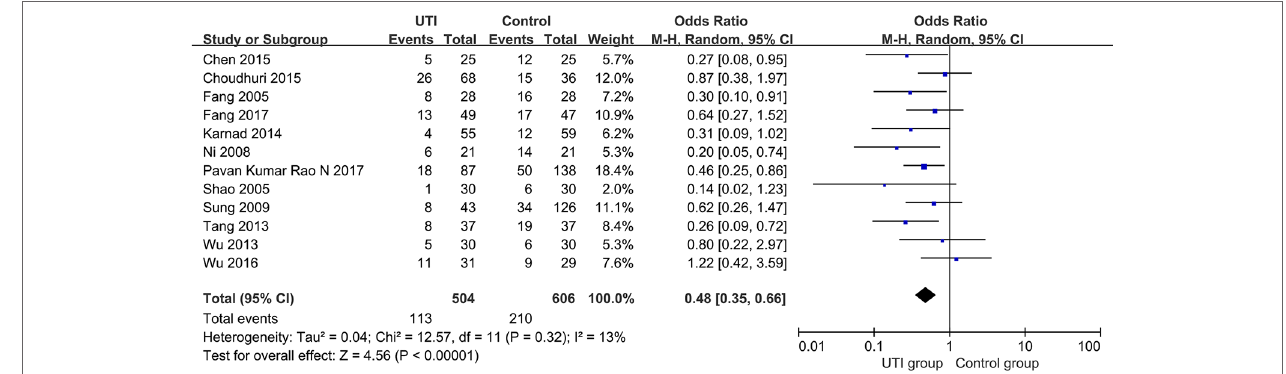
Levels of TNF- α